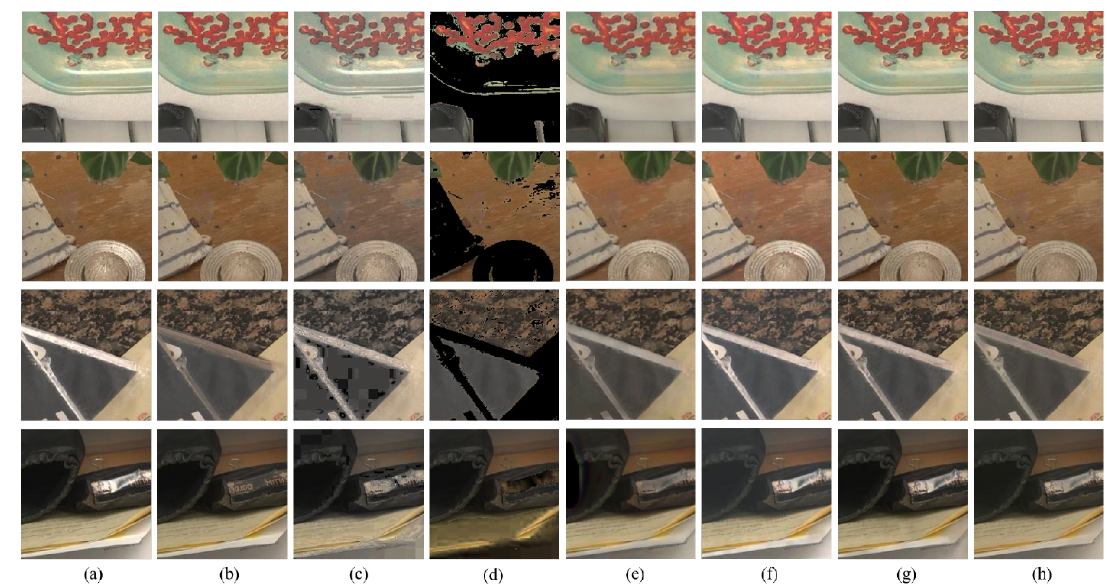
Fig. 5 Visual comparison of highlight removal methods on the SHIQ dataset: (a) input image, (b) ground-truth specular-free diffuse image, and results from (c) Shen et al. [11], (d) Yamamoto et al. [59], (e) Multi-class GAN [16], (f) Spec-CGAN [46], (g) JSHDR [50], and (h) our method.